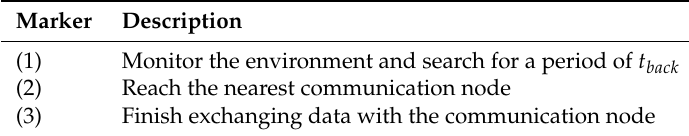
Figure 4. Behavior law to monitor the environment and search for static targets. Table 1. State transition condition in Figure 4 for static